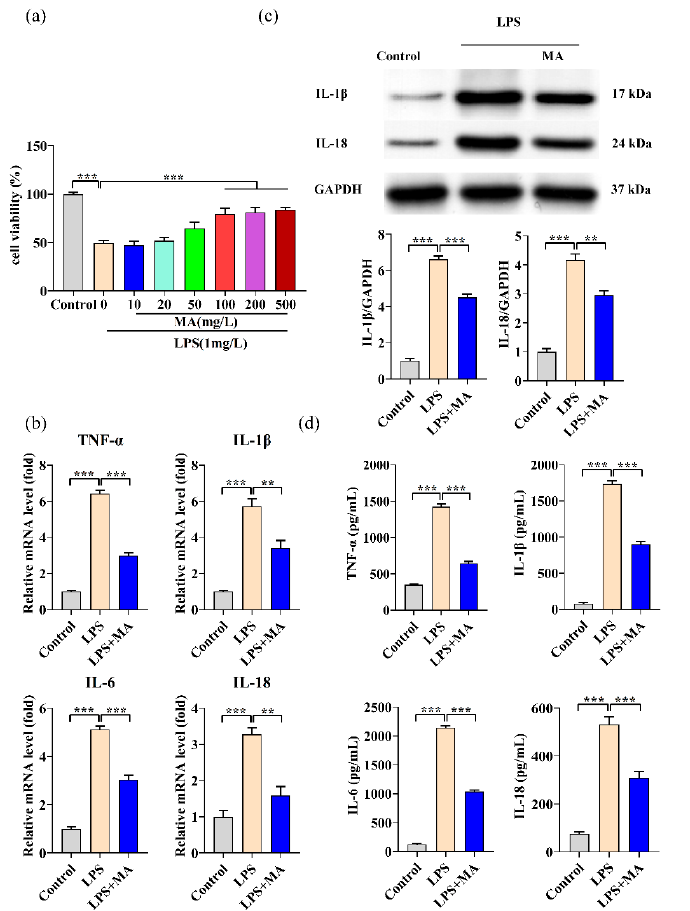
Figure 1. MA exhibits anti-inflammatory effects in LPS-induced RAW264.7 cells. ( a ) Cell viability was assessed by CCK-8 assay in RAW264.7 cells treated with different concentrations of MA (0-500 mg/L) for 12 h, followed by 1 mg/L LPS stimulation for 24 h. ( b ) qRT-PCR was performed to evaluate the mRNA expressions of TNF- α , IL-1 β , IL-6, and IL-18 in RAW264.7 cells after treatment with 100 mg/L MA for 12 h, followed by stimulation with 1 mg/L LPS for 24 h. ( c ) Western blot was performed to detect the protein levels of IL-1 β and IL-18 in RAW264.7 cells. ( d ) ELISA was conducted to detect the levels of inflammatory cytokines including TNF- α , IL-1 β , IL-6, and IL-18 in RAW264.7 cells. Data are shown as mean ± SEM obtained from three independent experiments. ** p < 0.01, *** p <